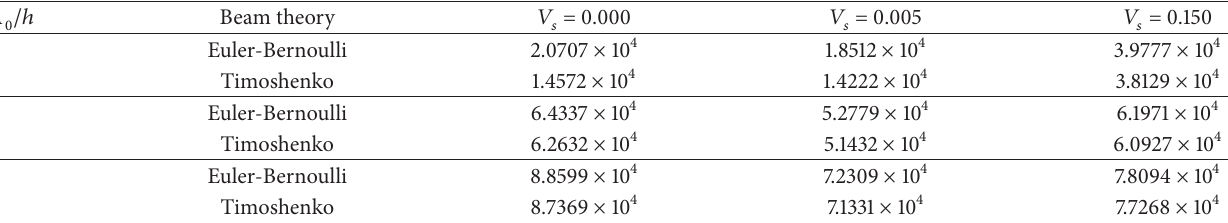
𝑉 𝑉 𝑠 = 0.000 𝑠 = 0.005 𝑠 =